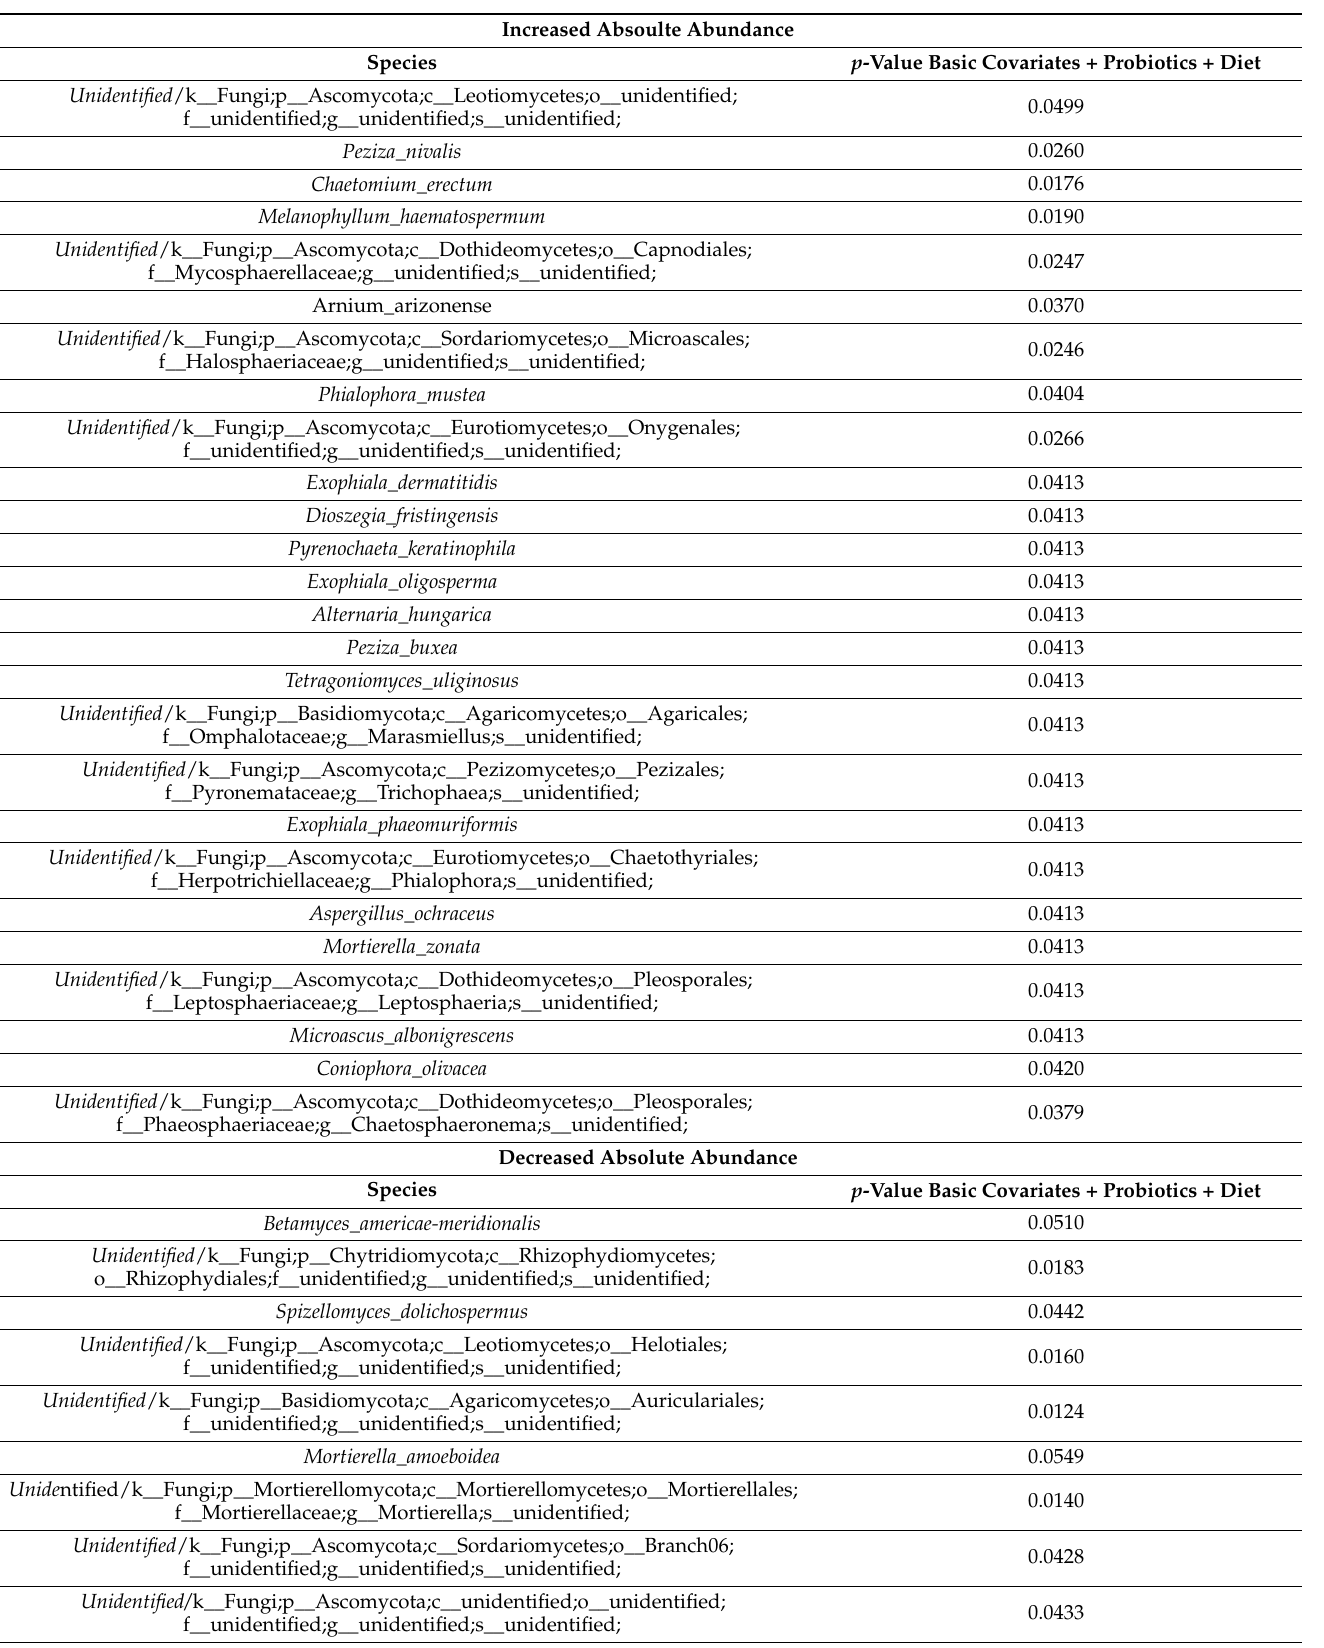
Table 7. Significant absolute abundance in NDD compared to CTRL at the species